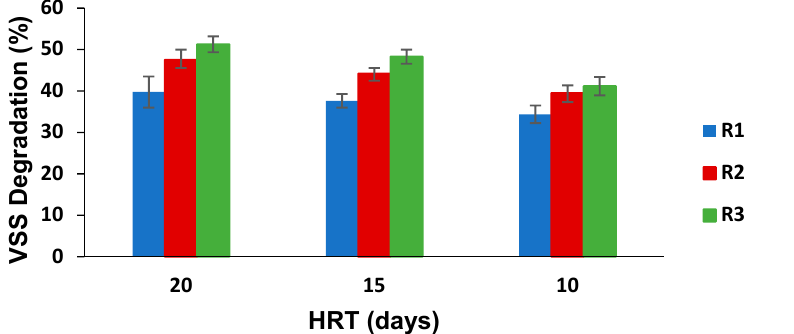
Figure 2. VSS degradation for the R1 (control), R2 (thermal pre-treatment), and R3 (micro-aerobic pre-treatment) digesters at 20, 15, and 10 days of HRT.